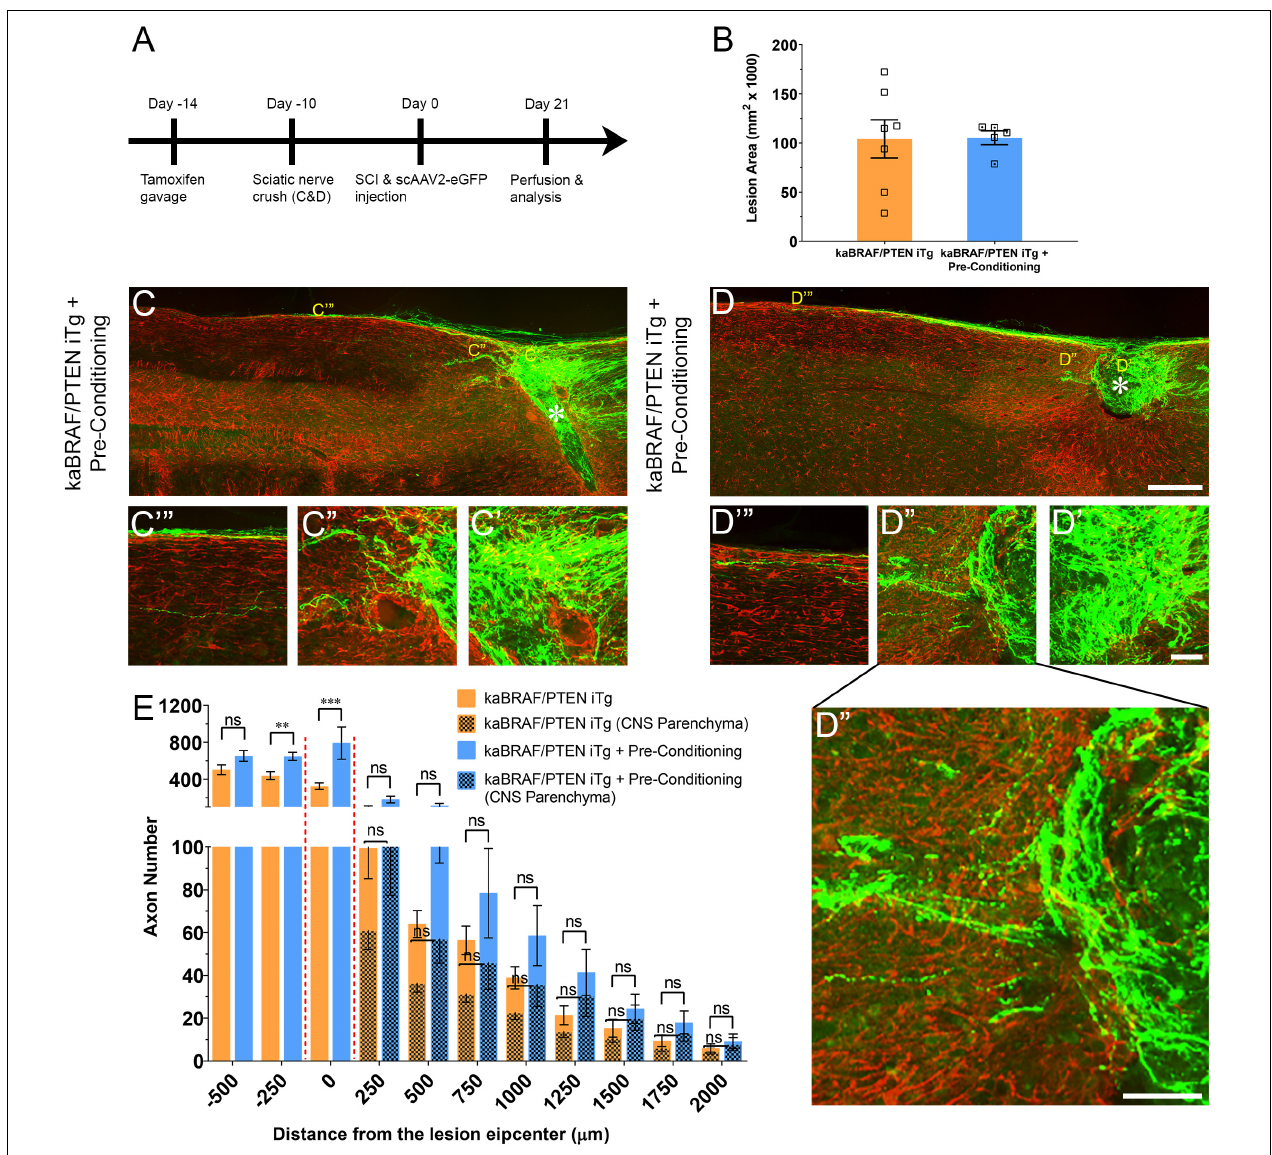
FIGURE 3 | Additive effect of pre-conditioning lesion and concomitant B-RAF activation and PTEN deletion in promoting DC axon regeneration. (A) Schematic diagram showing the experimental timeline. Four days after the first tamoxifen gavage a group of kaBRAF/PTEN iTg mice underwent right sciatic nerve crush (kaBRAF/PTEN iTg + Pre-Conditioning). Both kaBRAF/PTEN iTg + Pre-Conditioning and kaBRAF/PTEN iTg mice then underwent dorsal SCI and scAAV2-eGFP injection into the right L4 and L5 DRGs to label regenerating DC axons 2 weeks after the first tamoxifen gavage. (B) Quantitative analysis of the lesion area after SCI in kaBRAF/PTEN iTg versus kaBRAF/PTEN iTg + Pre-Conditioning mice. (C–D (cid:48)(cid:48)(cid:48) ) Representative images of two kaBRAF/PTEN iTg + Pre-Conditioning lesion mouse spinal cords showing a large number of regenerating DC axons immediately caudal to the lesion and numerous axons within the lesion epicenter. ∗ Indicates lesion epicenter. (E) Quantitative comparison of regenerated DC axons in kaBRAF/PTEN iTg group versus kaBRAF/PTEN iTg + Pre-Conditioning lesion group. Significantly increased DC axon regeneration is evident at 250 µ m caudal to the lesion in the combined group ( ∗∗ P = 0.0037, df = 10), and at the lesion epicenter (0 µ m: ∗∗∗ P < 0.001, df = 10). Two-way ANOVA with repeated measures. n = 7 (kaBRAF/PTEN iTg) and 5 (kaBRAF/PTEN iTg + Pre-Conditioning). [ (E) patterned] Quantitative comparison of regenerated DC axons within the CNS parenchyma rostral to the SCI in kaBRAF/PTEN iTg versus kaBRAF/PTEN iTg + Pre-Conditioning group. Scale bars, 250 µ m (C,D) , 50 µ m (C (cid:48) –C (cid:48)(cid:48)(cid:48) ,D (cid:48) –D (cid:48)(cid:48)(cid:48) ) , ns, not significant.